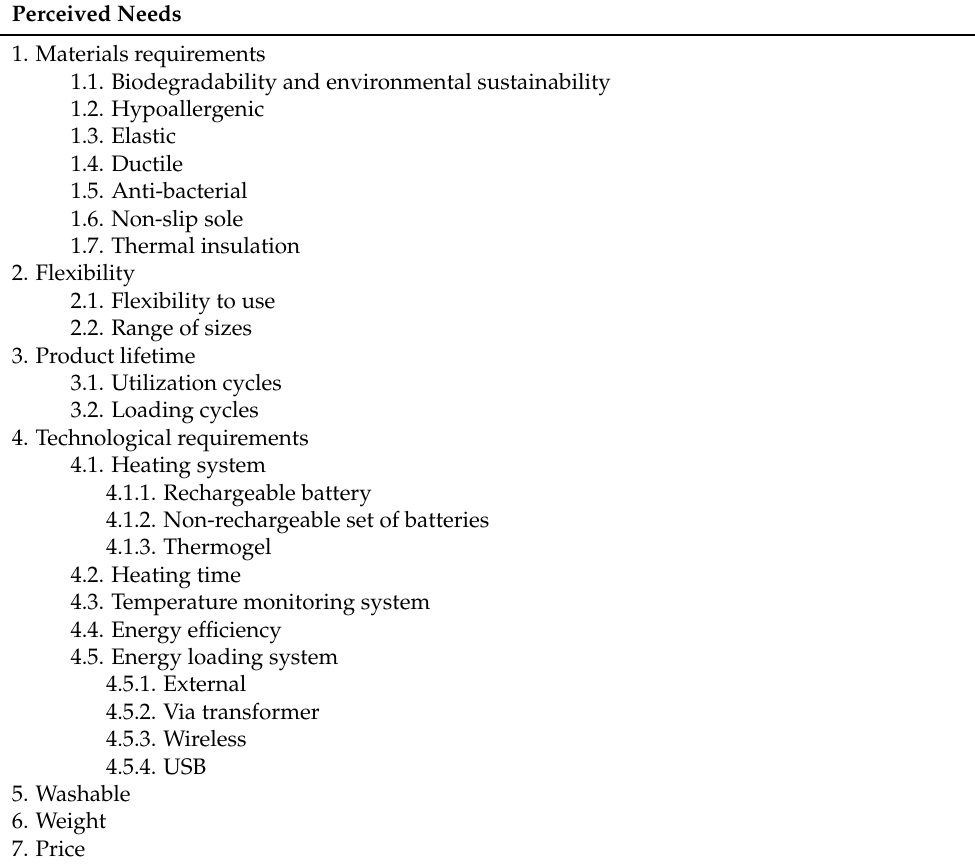
Table 2. Perceived needs hierarchically